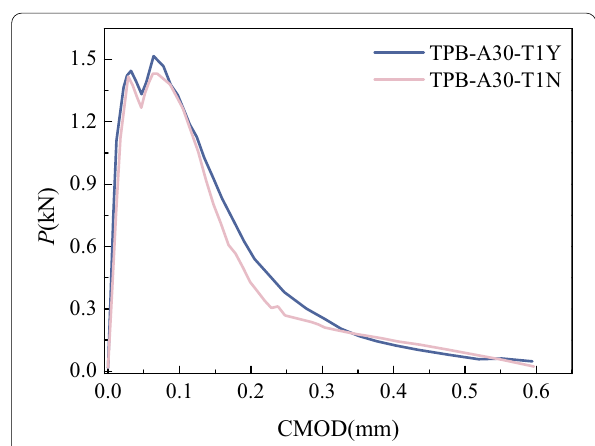
0.0 Fig. 21 P ‑CMOD curves of models TPB‑A30‑T1Y and